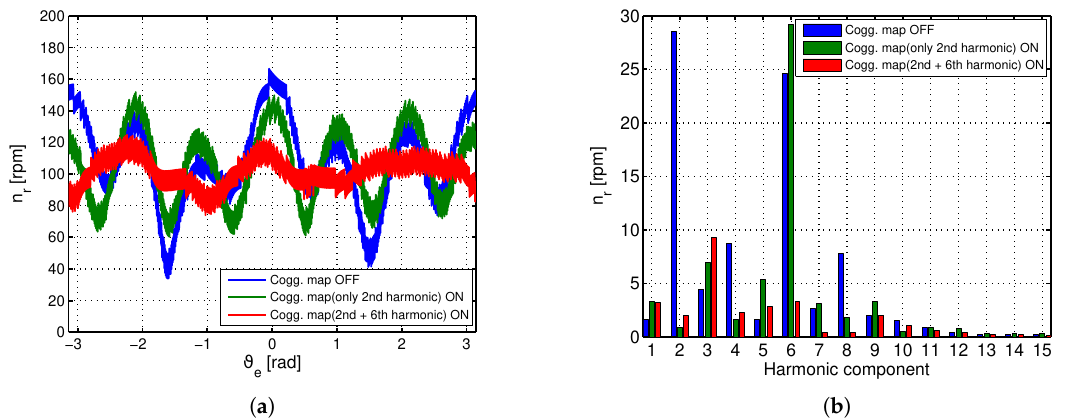
Figure 10. ( a ) speed ripple; ( b ) FFT of speed waveform, required n r = 100 rpm.